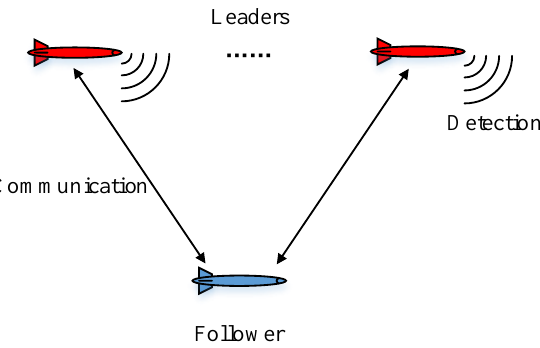
Figure 1. The leader–follower structure.